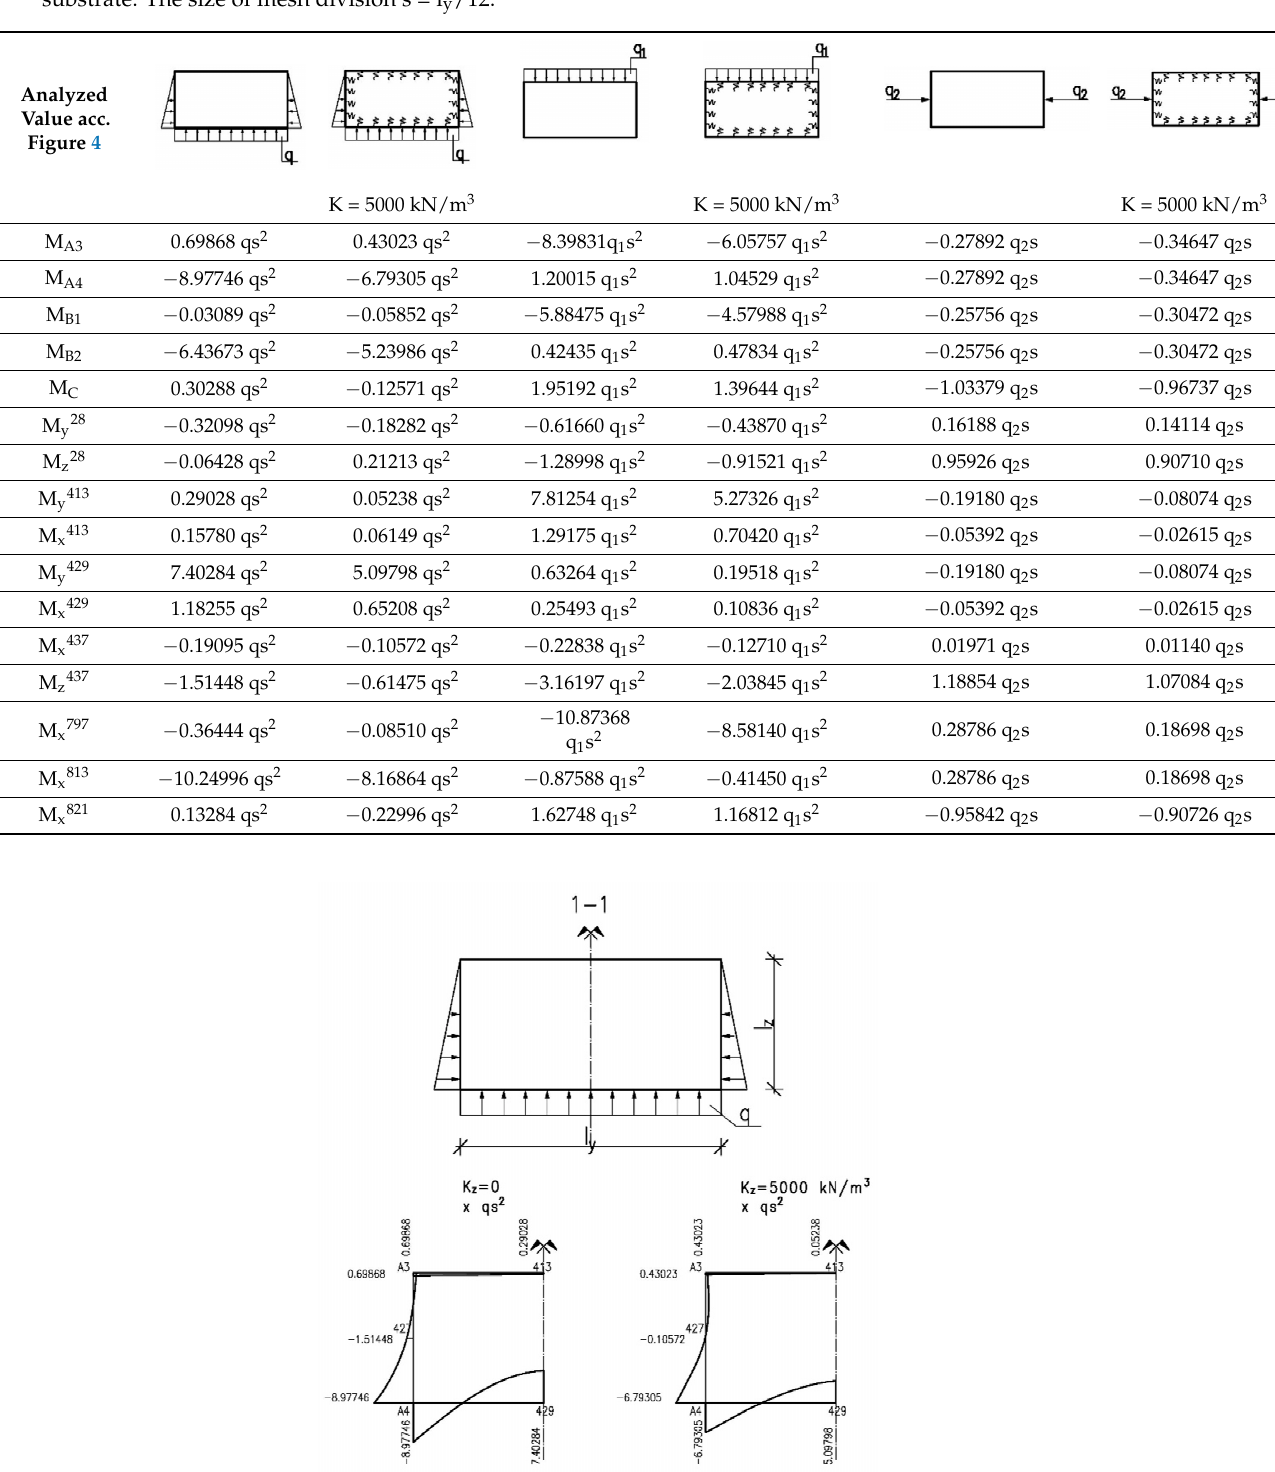
Figure 6. Charts of bending moments due to the hydrostatic load of the walls and the uniform load of the bottom without taking into account the effect of an elastic substrate and for the Pois- son’s ratio ν = 0 and taking into account the effect of an elastic substrate K = 5000 kN/m 3 and for